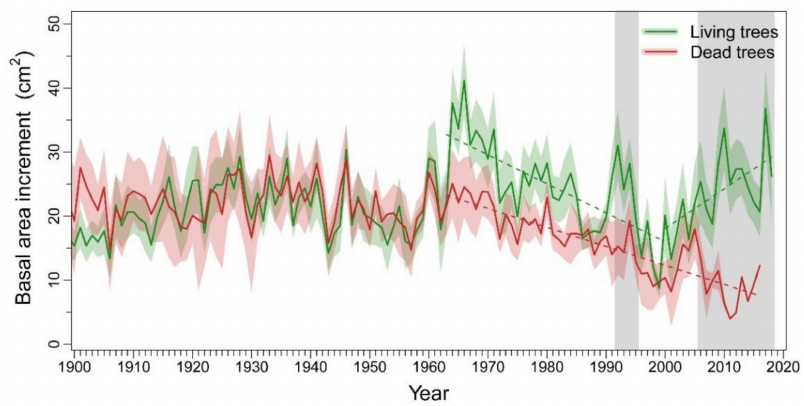
Figure 1. Basal area increment (BAI) of living (L; green) and dead (D; red) Nothofagus dombeyi trees. Solid lines represent the mean BAI for each tree-vigor class and shaded areas around them the standard error of the mean. Dash lines show significant ( p < 0.05) trends in mean BAI before and after detected break point dates. The grey filled areas indicate the periods when BAI of L and D trees significantly ( p < 0.05) differed according to Wilcoxon rank-sum tests.